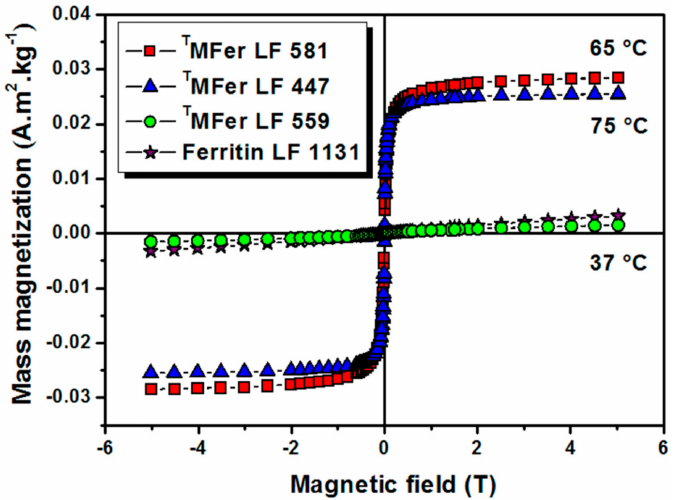
Figure 3. Magnetization curves of magnetoferritin. Data were obtained at 22 ◦ C for T MFer (mag- netoferritin) with LF (loading factor): 581, 447, and 559 prepared at various synthesis temperatures marked on the graph (37, 75 and 65 ◦ C). T prefix in T MFer labeling was used for specification of magnetoferritin samples prepared at three different synthesis temperatures with similar